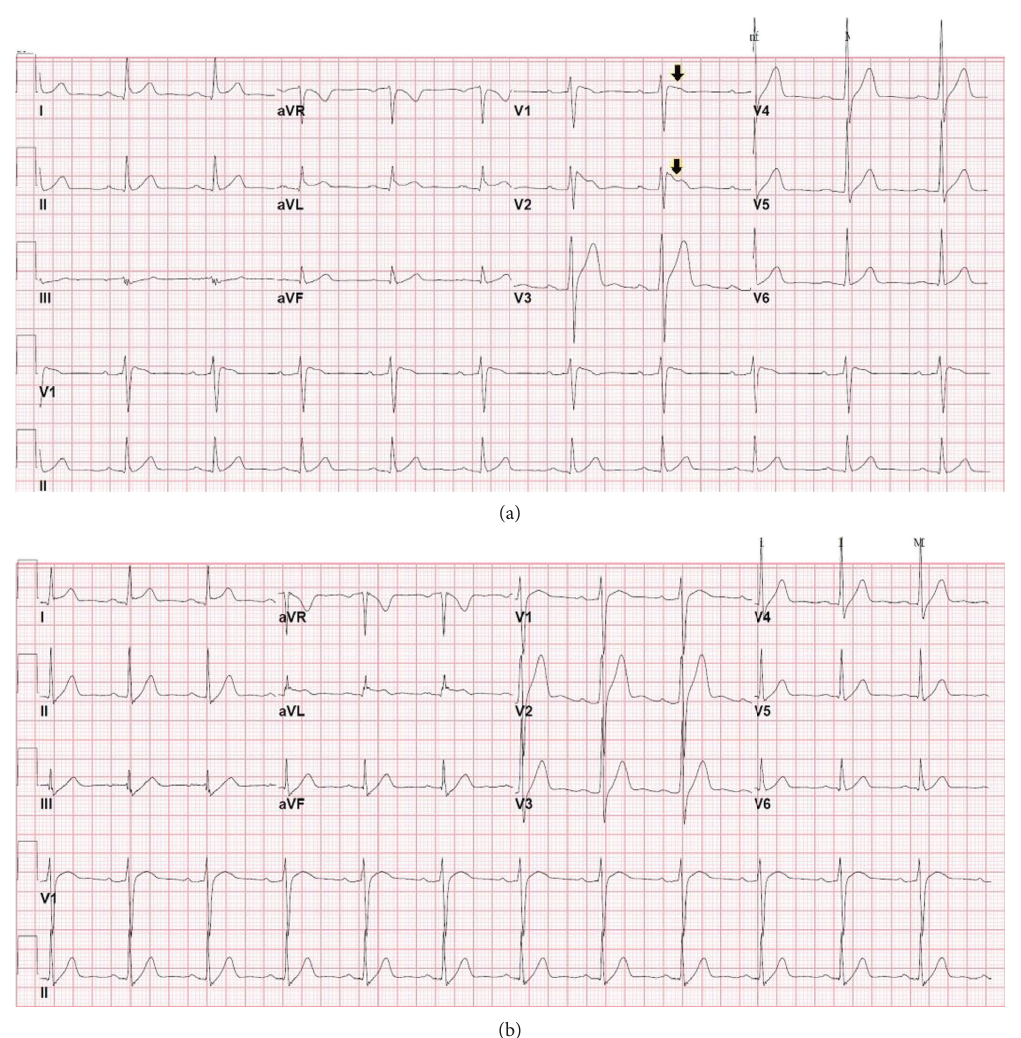
Figure 2: Electrocardiograms revealing recurrence of the Brugada pattern in the setting of recreational drug use (a, arrow) and complete resolution after approximately 24 hours without substance use